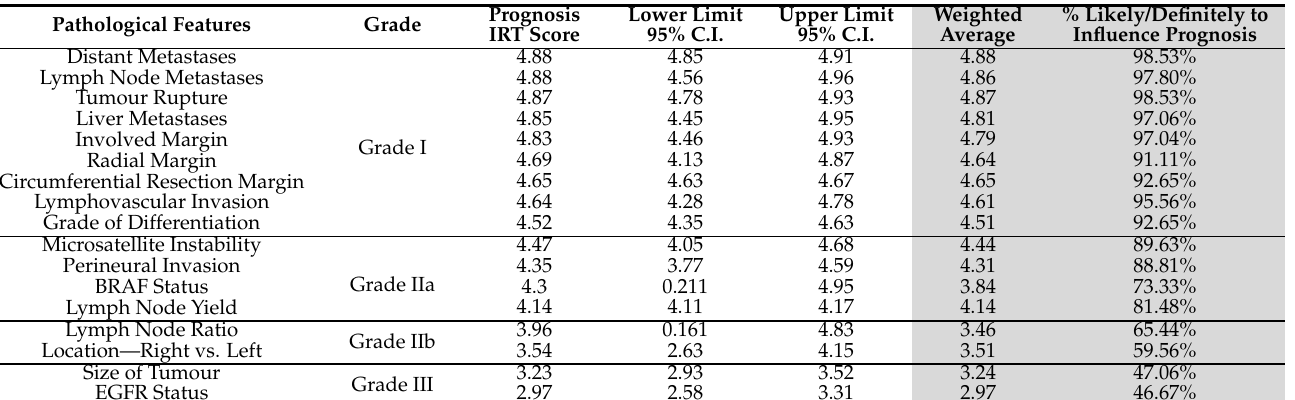
Table 3. Item Response Theory (IRT) and weighted average scores for pathological features influenc-